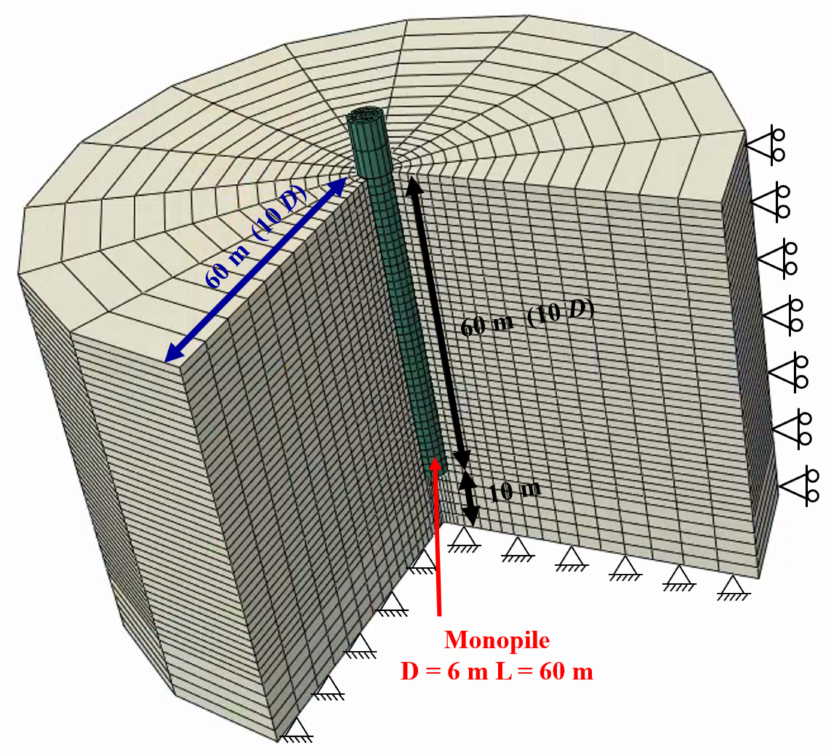
Figure 1. Diagram of the three-dimensional finite element mesh and boundary